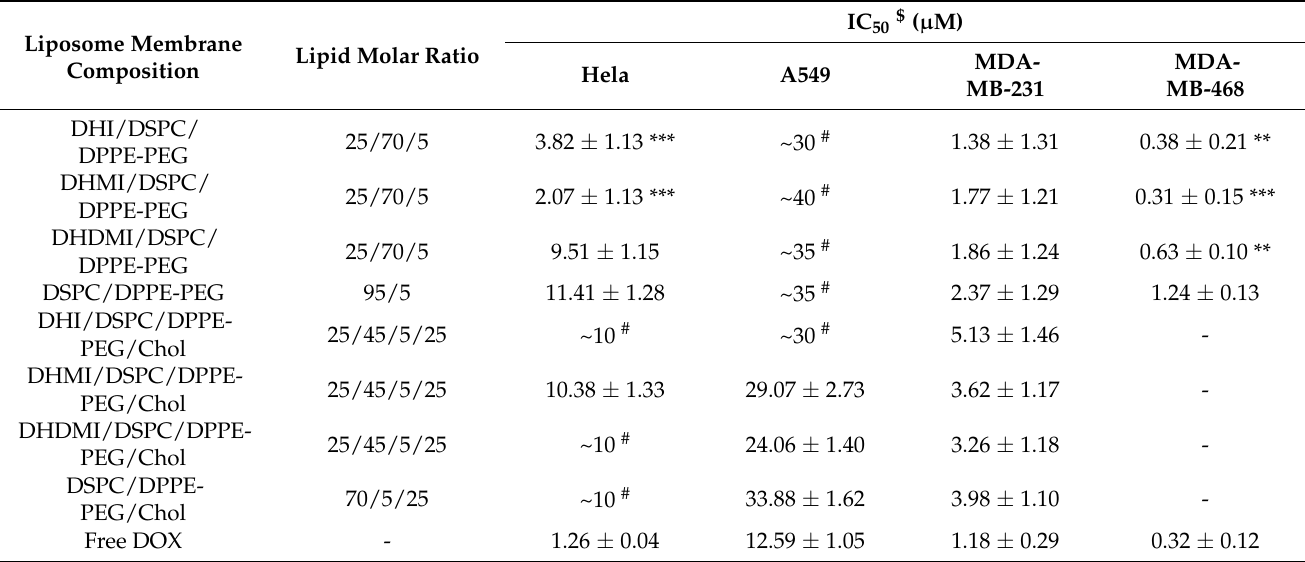
Table 2. IC50 values of DOX-loaded liposomes and free DOX on HeLa, A549, MDA-MB-231, and MDA-MB-468 3D